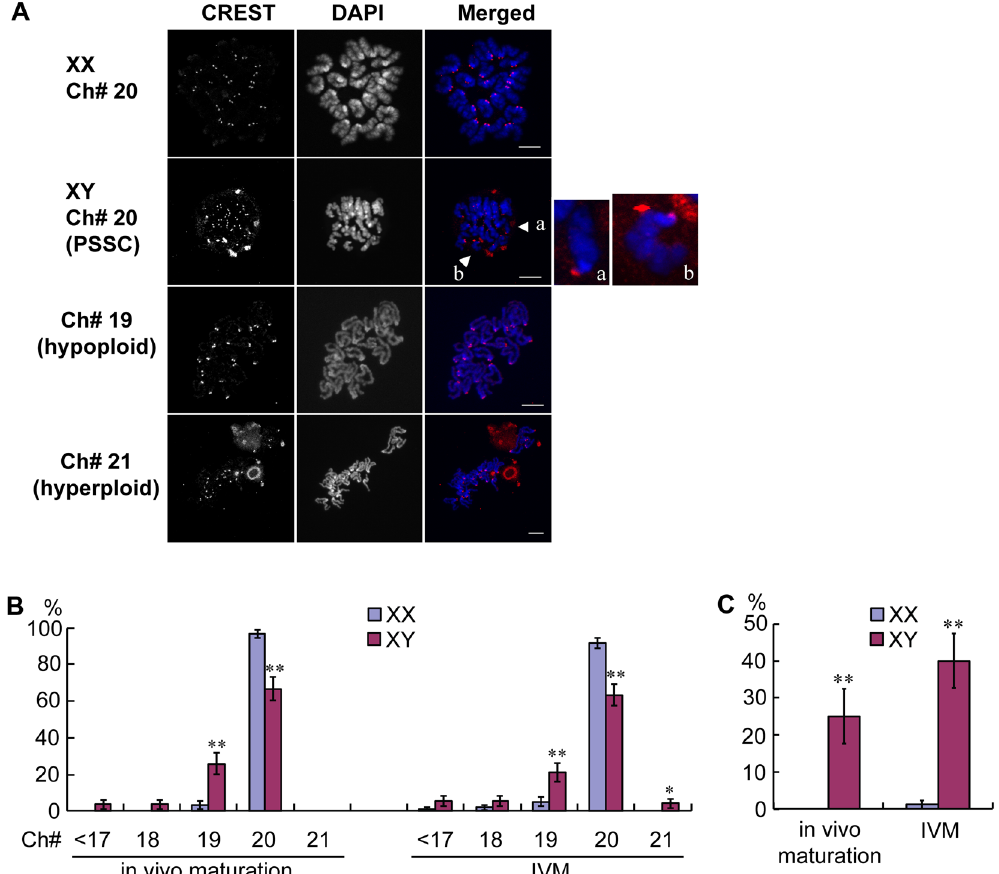
Figure 4. Higher frequency of aneuploidy in the MII-oocytes from XY females. ( A ) Examples of aneuploidy analyses. While almost all oocytes from XX females showed normal number ( = 20) of chromosomes, the oocytes from XY females showed variable numbers such as hypoploid (e.g. 19) or hyperploid (e.g., 21). The oocyte with the normal number of chromosomes often showed precocious separation of sister chromatids (PSSC). Bar: 10 µ m. The areas around the chromatids indicated by (a) and (b) are magnified in the right panels. ( B ) Percentages of oocytes with normal ( = 20) and abnormal chromosome numbers. ( C ) Percentages of oocytes with PSSC. Data are shown as means ± SEM. * and ** significant differences at p < 0.05 and 0.01, respectively. The experiments were repeated at least three times each. For in vivo maturation, total 60 and 54 oocytes from XX and XY females, respectively, were examined. For IVM, total 95 and 73 oocytes from XX and XY females, respectively, were